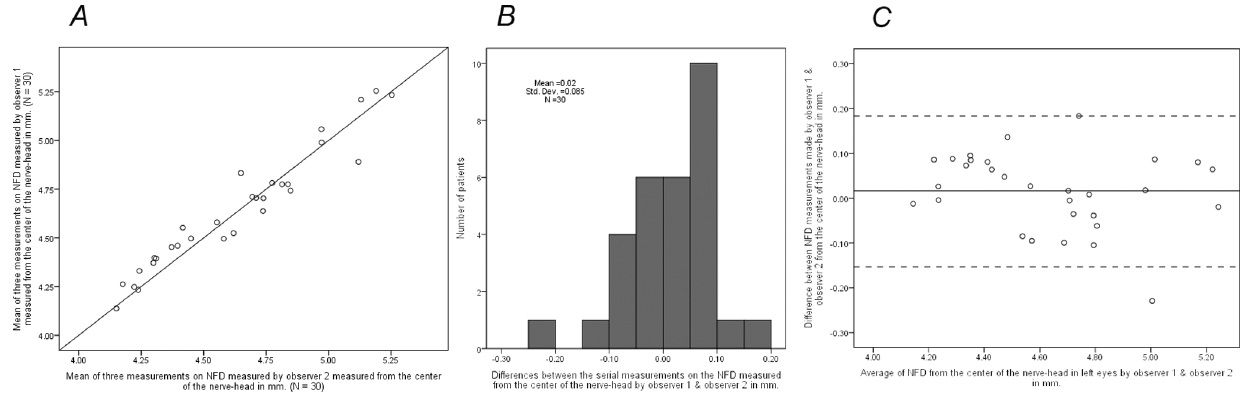
Figure 6. A. NFD made by observer 1 plotted against this measurement made by observer 2 together with the line of equation. B. the distribution of differences of the NFDs between the two observers. C. The difference between NFDs against NFD averaged over both observers. The solid line indicates the mean and the dotted lines the 95% limits of agreement.